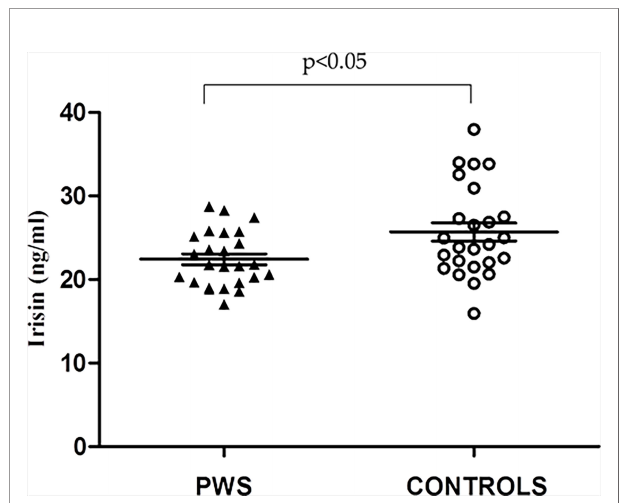
FIGURE 1 | Individual values of circulating irisin levels obtained in Prader Willi Syndrome (PWS) patient (black triangles) and controls (white circles). Lines represent mean ± standard error of the mean (SEM)